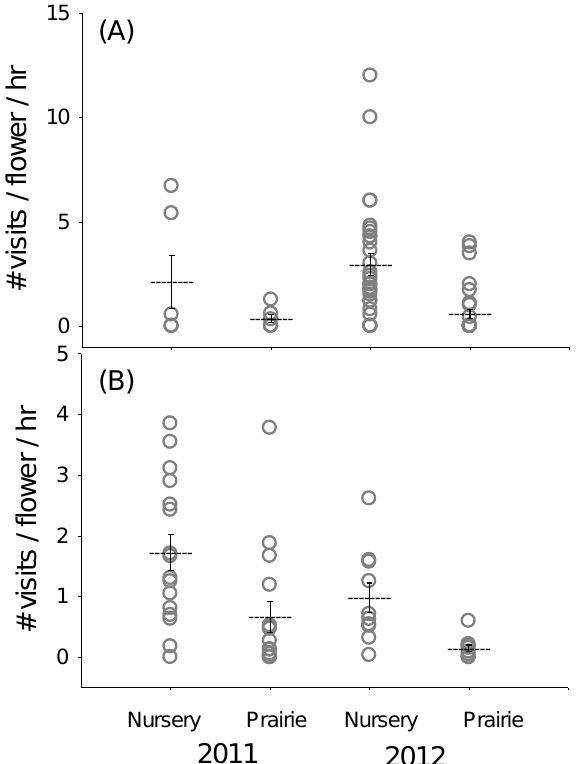
F IGURE 2. Overall insect visitation rates (# visits / plant / hr) at Webster Nursery and Johnson Prairie for: A) Balsamorhiza deltoidea, and B) Lupinus albicaulis in 2011 and 2012. Open gray circles represent each visitation rate and black horizontal lines represent means +/- 1 standard error. Bonferroni correction for two tests would necessitate an alpha = 0.025.